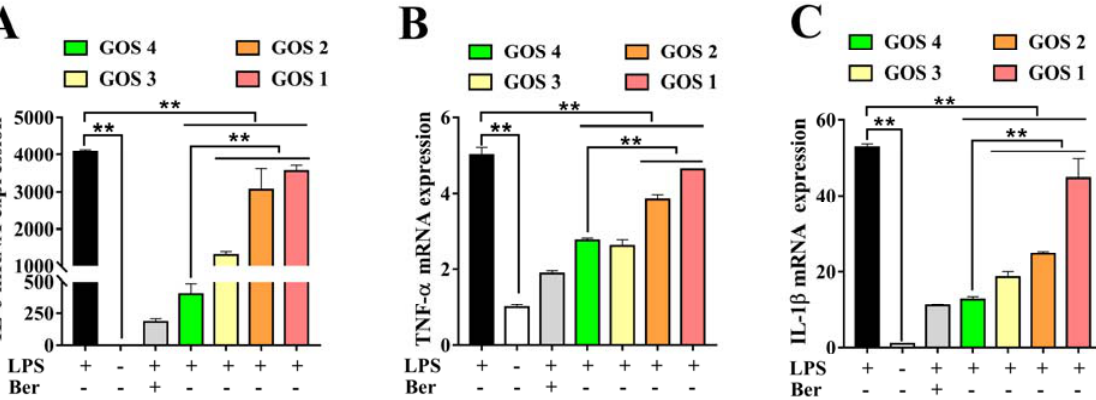
Figure 4. Effects of GOS1-4 pro-inflammatory cytokine mRNA expression in LPS-induced RAW264.7 macrophages: ( A ) IL-6, and ( B ) TNF- α , and ( C ) IL-1 β . One-way ANOVA combined with Duncan’s test, ** p < 0.01, the difference was statistically significant.